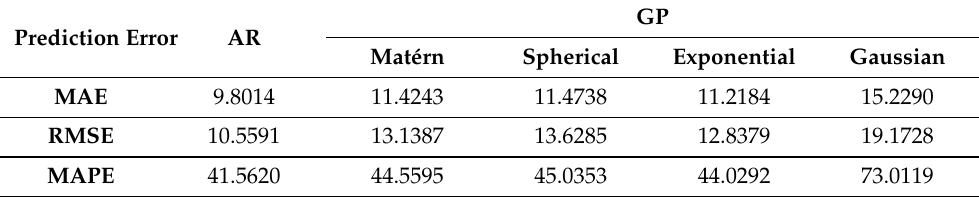
Table 2. Temporal forecasting error of GP and AR models.